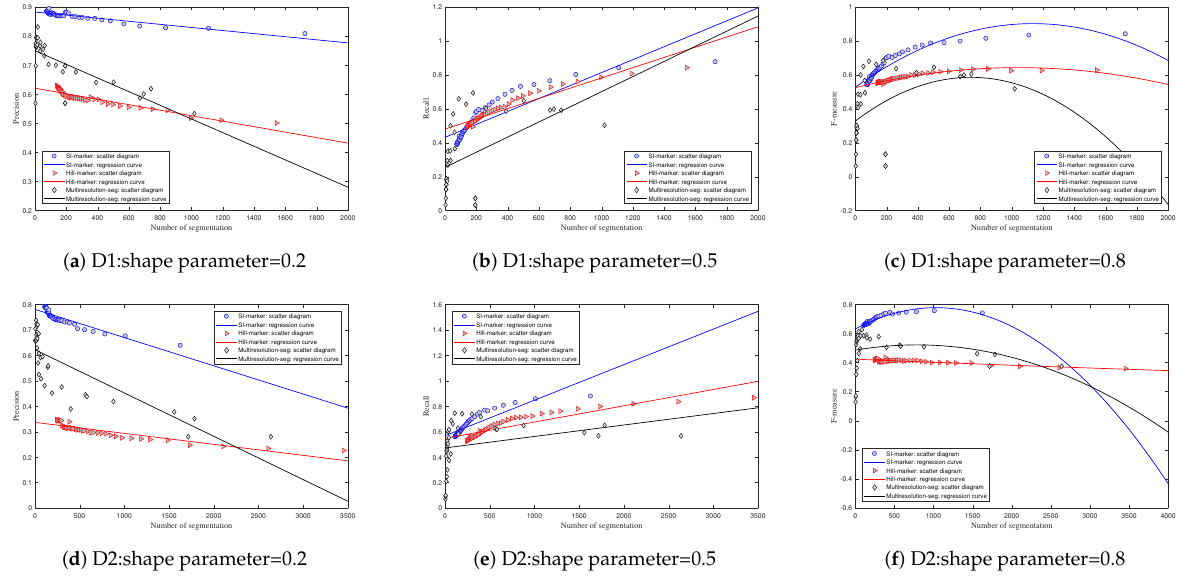
( e ) D2:shape parameter=0.5